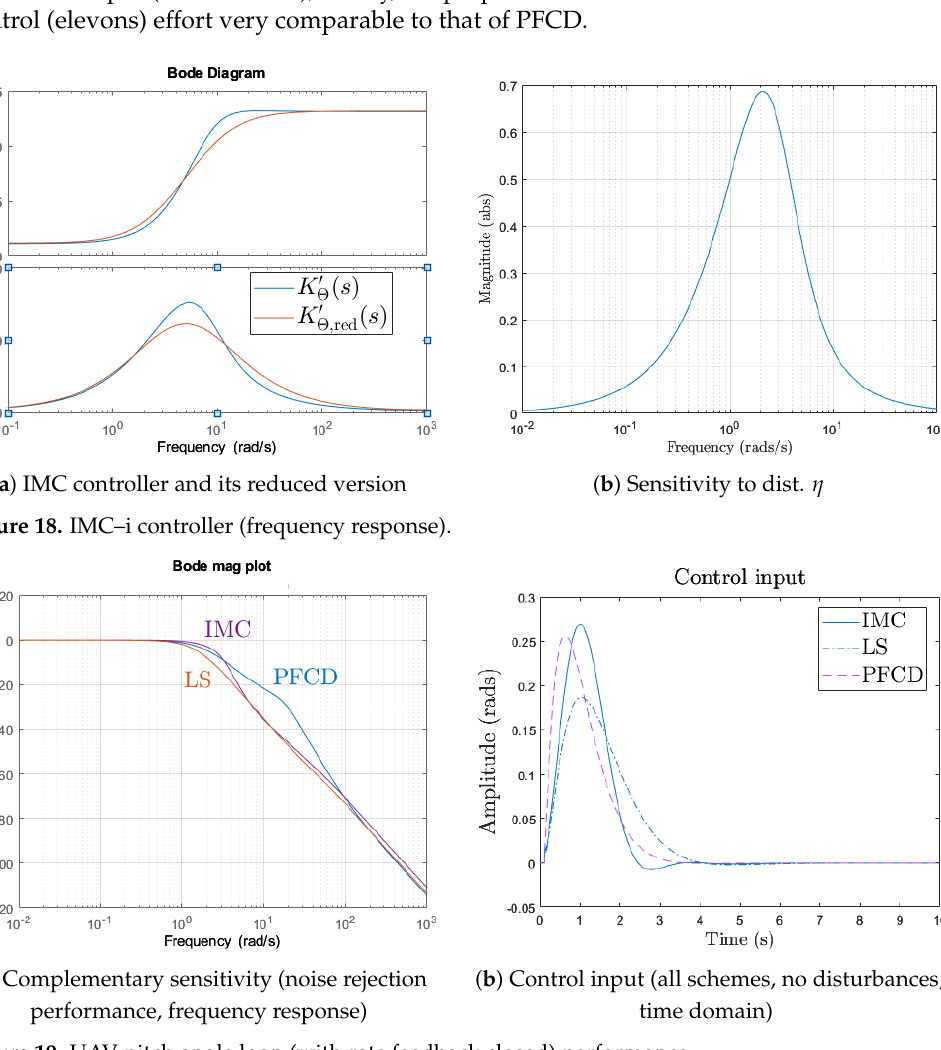
Figure 19. UAV pitch angle loop (with rate feedback closed)